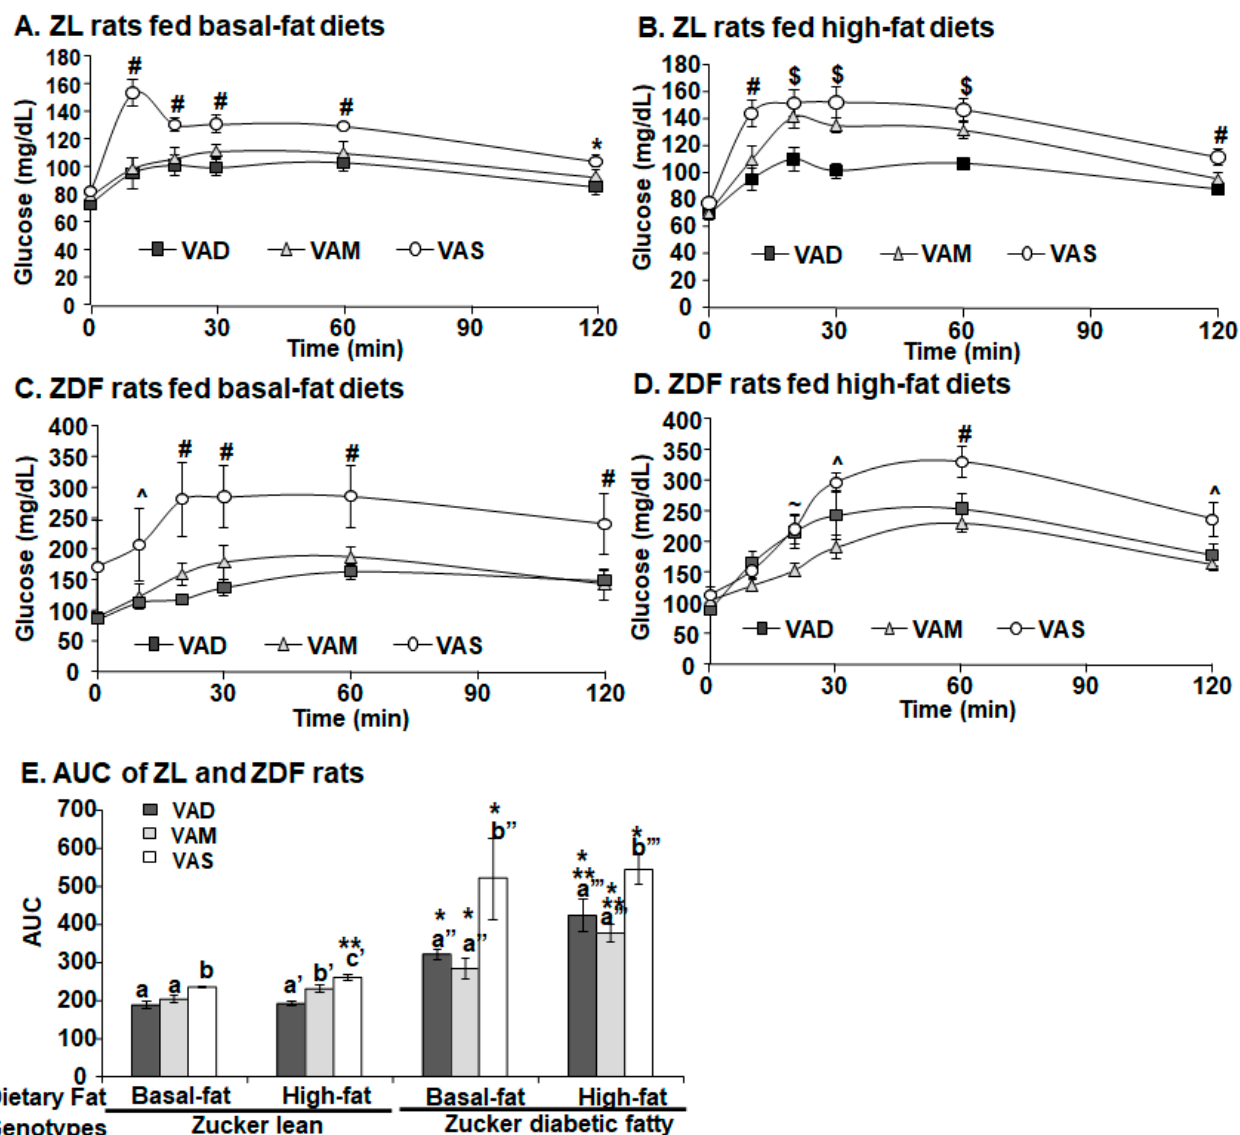
Figure 6. The peripheral blood glucose levels of ZL (A,B) and ZDF (C,D) rats fed a VAD, VAM or VAS diet with BF or HF content in the oral glucose tolerance test, and AUG (E). Data are presented as mean ± SEM; n = 5–6 per group. For ( A – D ), * for VAD < VAS; ^ for VAM < VAS; # for VAD/VAM < VAS; $ for VAD < VAM/VAS; ~ for VAM < VAD/VAS; all p < 0.05. For ( E ), a < b, a’ < b’, a” < b”, and a’’’ < b’’’ for comparing the groups in the same fat content and genotype using one ‐ way ANOVA; * for comparing ZL and ZDF groups with the same diet; ** for comparing BF with HF groups within the same genotype using Student’s t ‐ test. Figure 6E shows the area under the curve (AUC) values, calculated using the OGTT data. The AUG of ZL rats fed the VAS ‐ BF diet was higher than that of the rats fed the VAD ‐ BF and VAM ‐ BF diets. The AUC of VAS ‐ HF ZL rats was higher than that of the rats fed the VAM ‐ HF diet, which in turn was higher than that of the rats fed the VAD ‐ HF diet. The AUC values of ZDF rats fed the VAS ‐ BF or VAS ‐ HF diets were, respectively, higher than those of the rats fed the VAD ‐ BF and VAM ‐ BF, or VAD ‐ HF and VAM ‐ HF diets, demonstrating the improvement in glucose tolerance when the VA status is lowered in ZDF rats. When the AUG values of ZL and ZDF rats fed the same diet were compared, the ZDF rats had significantly higher AUG values than ZL rats, indicating the impaired glucose tolerance in the ZDF rats.